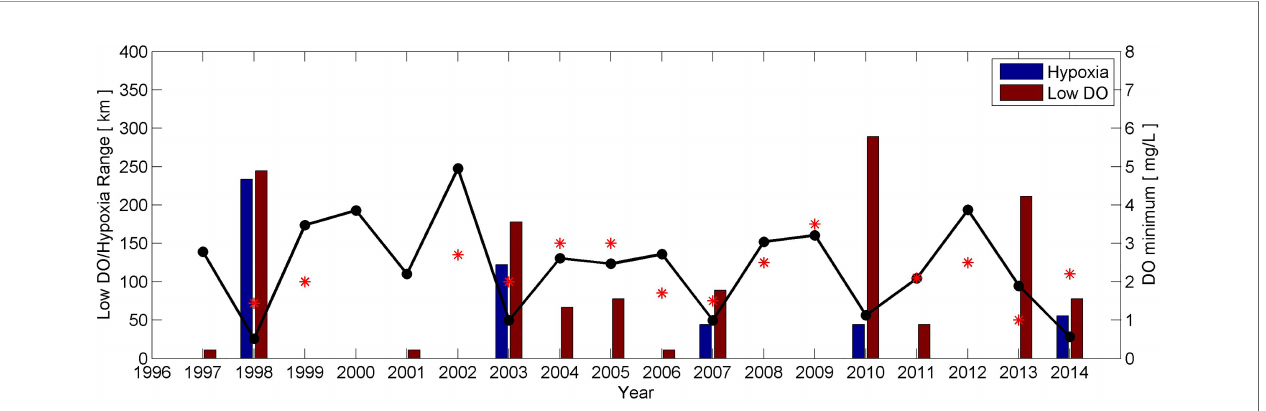
FIGURE 4 | The width of low-oxygen and hypoxia areas (units: km) and DO minimum (units: mg/L; in black) along Section C-C during 1997 – 2014. Red star denotes the DO minimum digitized by the previous observations in literatures (see Table S1 for